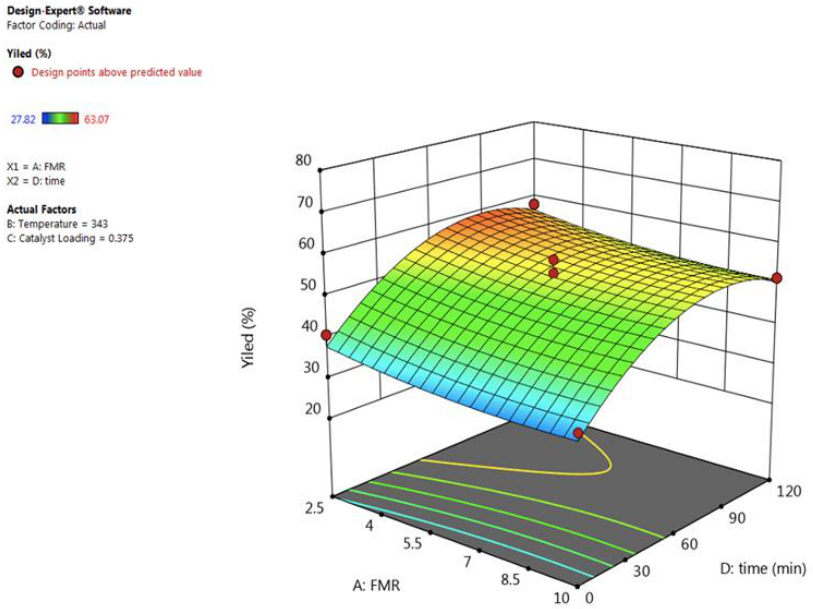
Figure 5. The effect of feed molar ratio on the yield of 1,2-epoxy-5-hexene. Based on the results of this study (Figure 6), it can be concluded that at 76 min, the optimal molar feed ratio of 1,5-hexadiene to TBHP was 2.76:1 at 348 K temperature and 0.56 mol% catalyst loading.